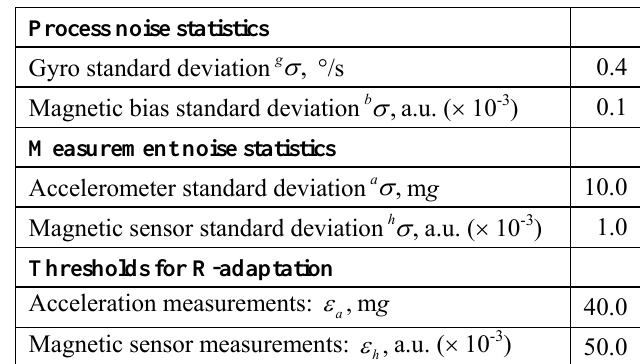
Table 1. Optimally tuned parameter setting for the EKF. The raw magnetic data from the MTx are expressed in arbitrary units (a.u.), since they are normalized to earth field strength by the manufacturer.